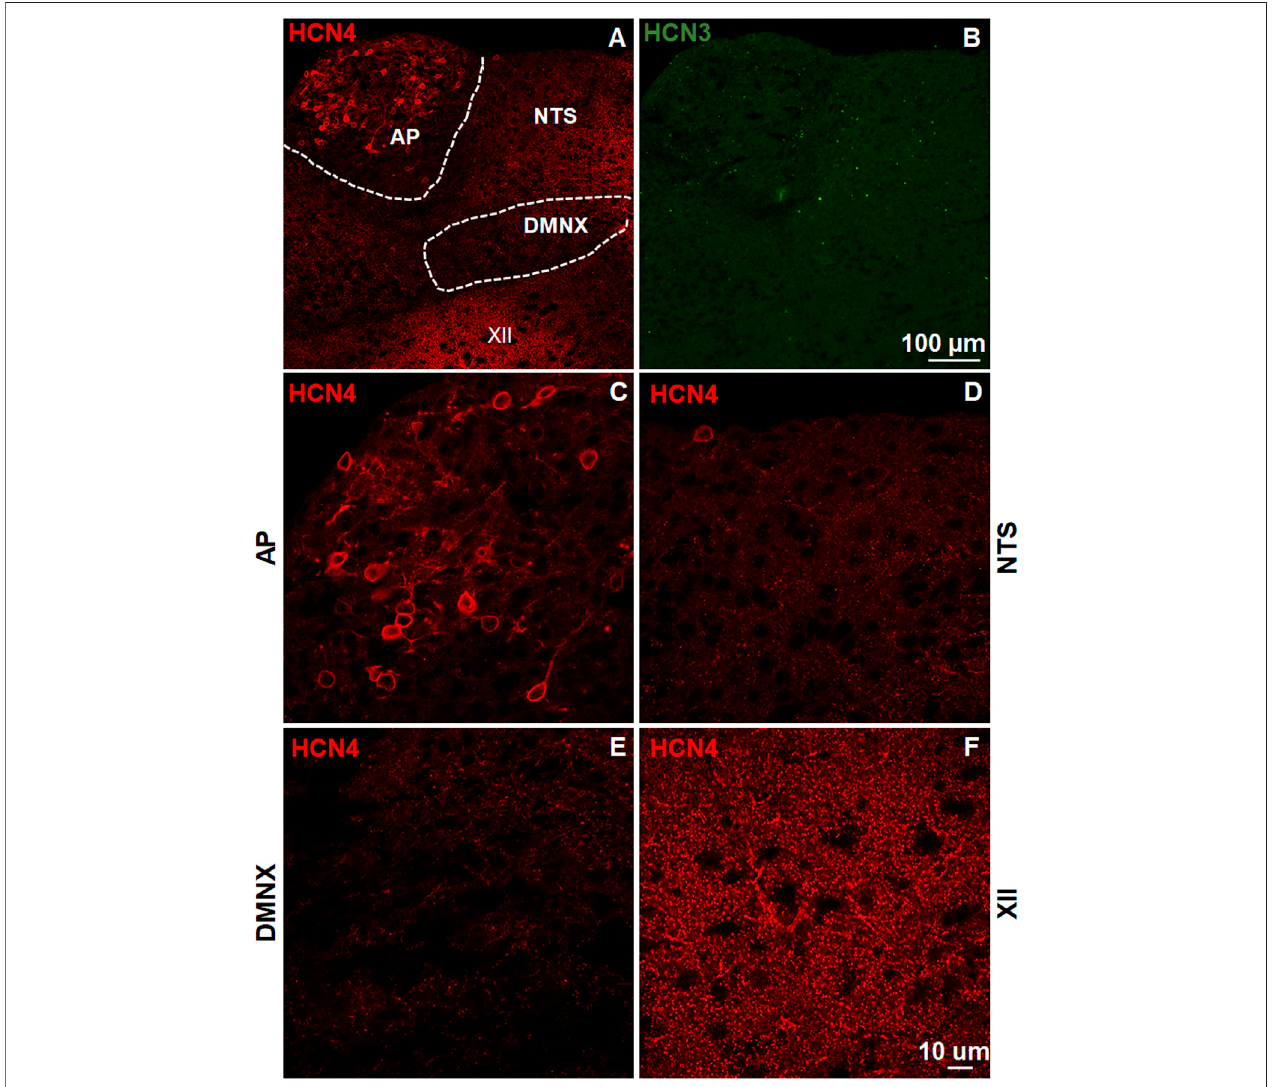
FIGURE2| ExpressionofHCNchannelsubtypes3and4.HCNchannelimmunostainingwithrabbitanti-HCN4andmouseanti-HCN3primaryantibodiesfollowed by Alexa Fluor 594 donkey anti-rabbit and 488 donkey anti-mouse secondary antibodies were performed on coronal brainstem sections (20 μ m) prepared from naïve least shrews. (A-B) Representative images (20x) show expression of HCN4 but not HCN3 observed in the least shrew brainstem dorsal vagal complex (DVC) area including three emetic nuclei, the area postrema (AP), the nucleus tractus solitarius (NTS) and the dorsal motor nucleus of the vagus (DMNX). Scale bar, 100 µm. (C – F) Representative images (60x) show differential expression of HCN4 observed in the area postrema (AP), the nucleus tractus solitarius (NTS), the dorsal motor nucleus of the vagus (DMNX) and the hypoglossal nuclei (XII). Scale bar, 50 µm.